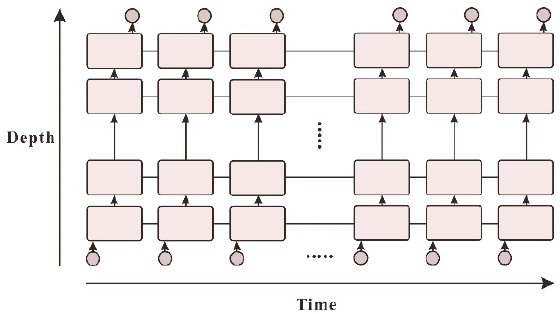
Figure 6. Structural diagram of Long Short-Term Memory Network.[18]